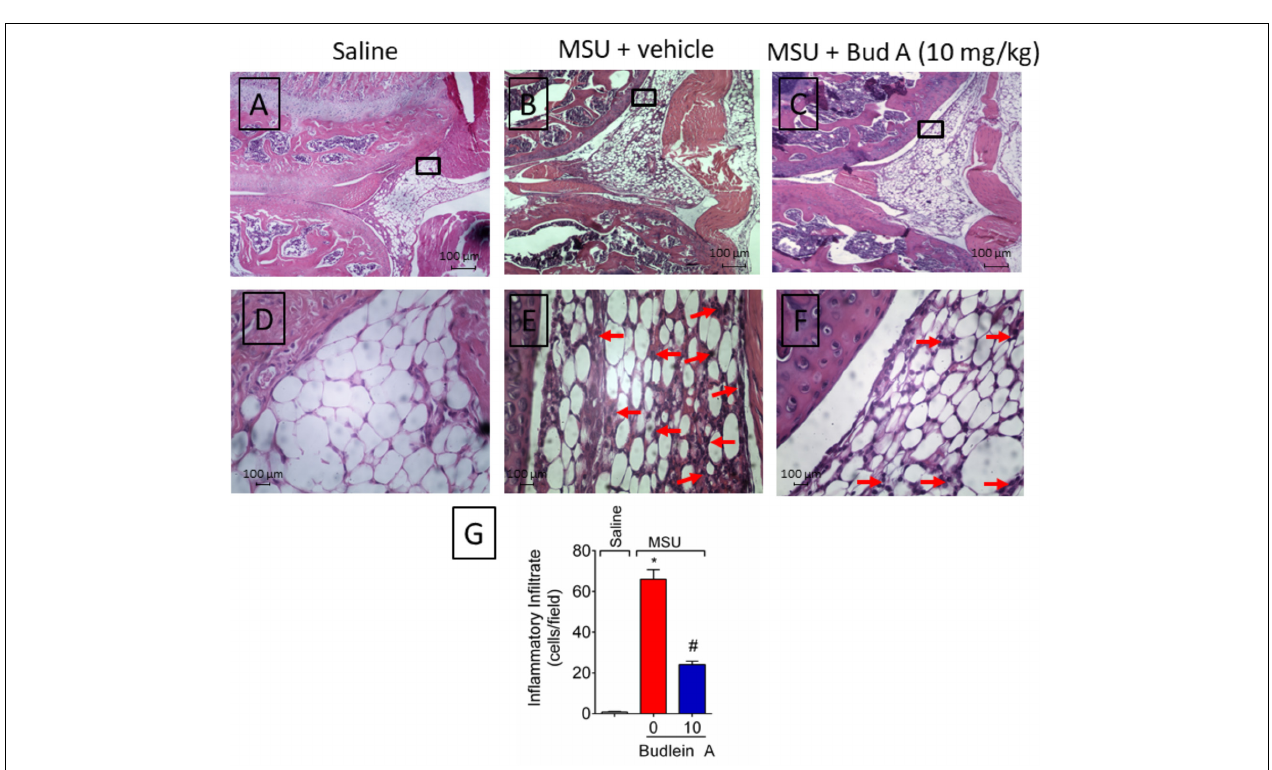
FIGURE 2 | Budlein A inhibits MSU-induced mononuclear cell and neutrophil recruitment to the knee joint. Fifteen hours after the injection of MSU crystals, knee joint wash was collected for determination of total leukocytes (A) , neutrophils (B) , and mononuclear cells (C) using Neubauer chamber (A) and Rosenfeld stained slices (B,C) . ∗ p < 0.05 vs. saline group; # p < 0.05 vs. 0 mg/kg group, one-way ANOVA followed by Tukey’s post hoc .